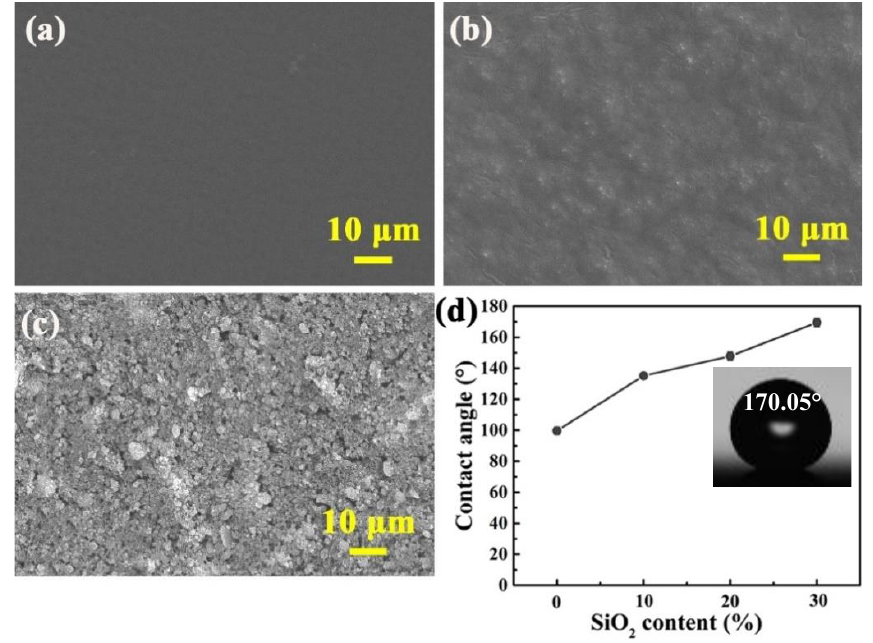
Figure 1. Surface micro-topography and contact angle change of ( a ) PTFE, ( b ) PTFE + 10%SiO 2 and ( c ) PTFE + 30%SiO 2 . ( d ) Variation of contact angle with particle addition.